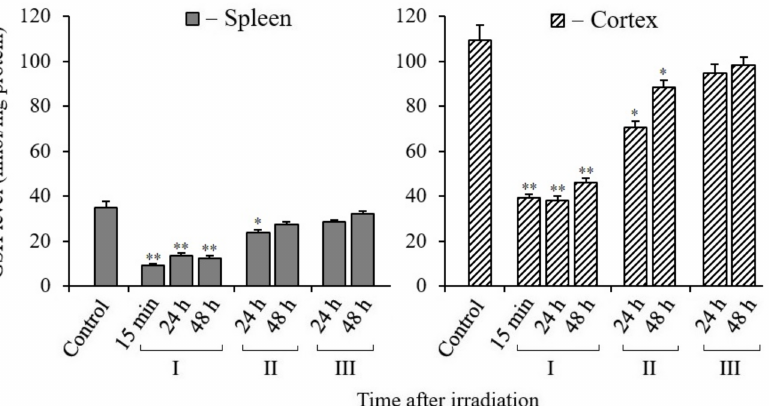
Figure 7. Changes in the GSH in spleen and cerebral cortex tissues of mice 15 min, 24, and 48 h after their irradiation. I—mice without MEL administration; II—MEL administration before irradiation; III—MEL administration after irradiation. The data are presented as mean ± SEM of 5–6 independent experiments. Statistical significance was set at * p < 0.05, ** p <